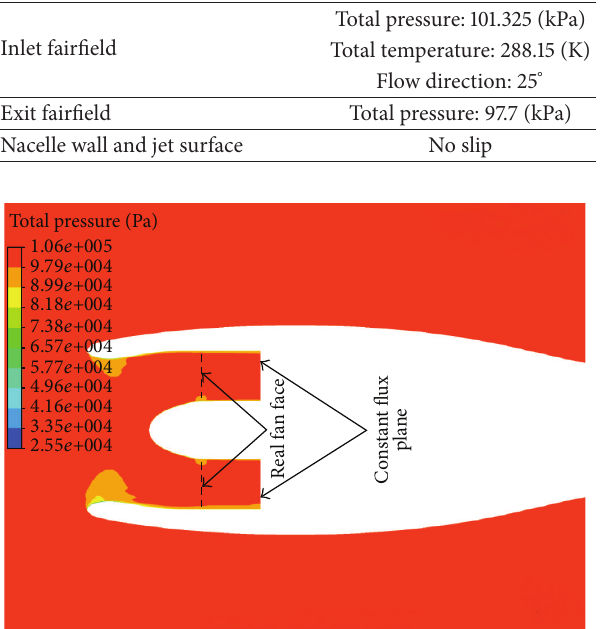
Table 1: General boundary conditions.